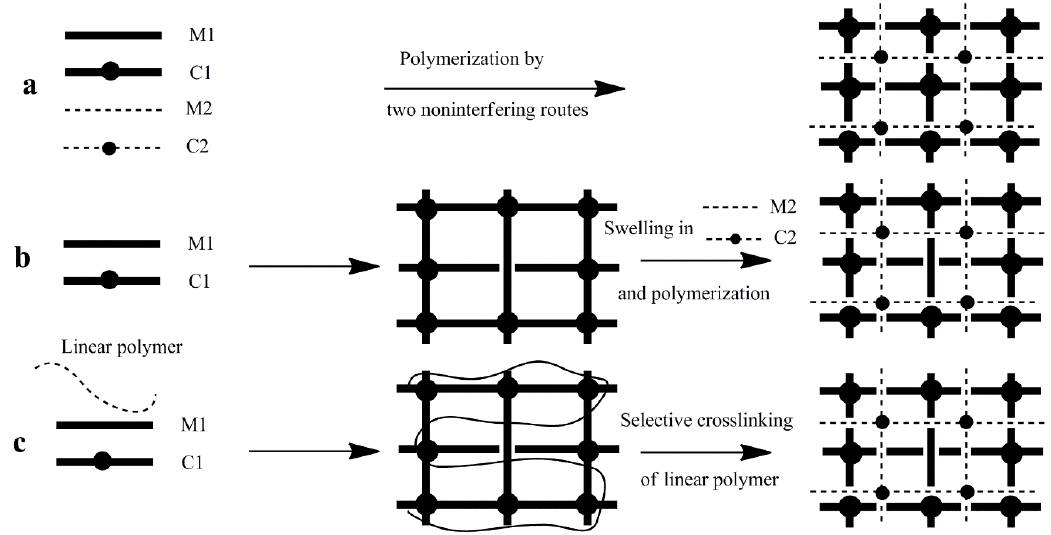
Figure 9. Proposed reaction mechanism of interpenetrating network (IPN) formation: ( a ) simultaneous strategy; ( b ) sequential strategy; ( c ) selective crosslinking of a linear polymer entrapped in semi-IPN [96] .